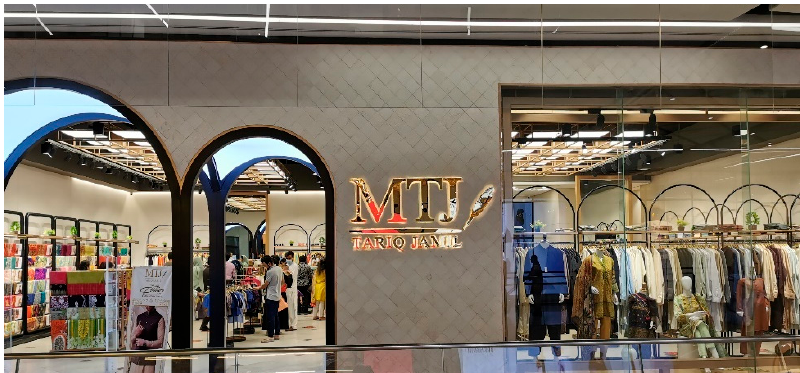
Figure 13. A MTJ store in Lahore’s prestigious Emporium Mall. Source: author’s photo.